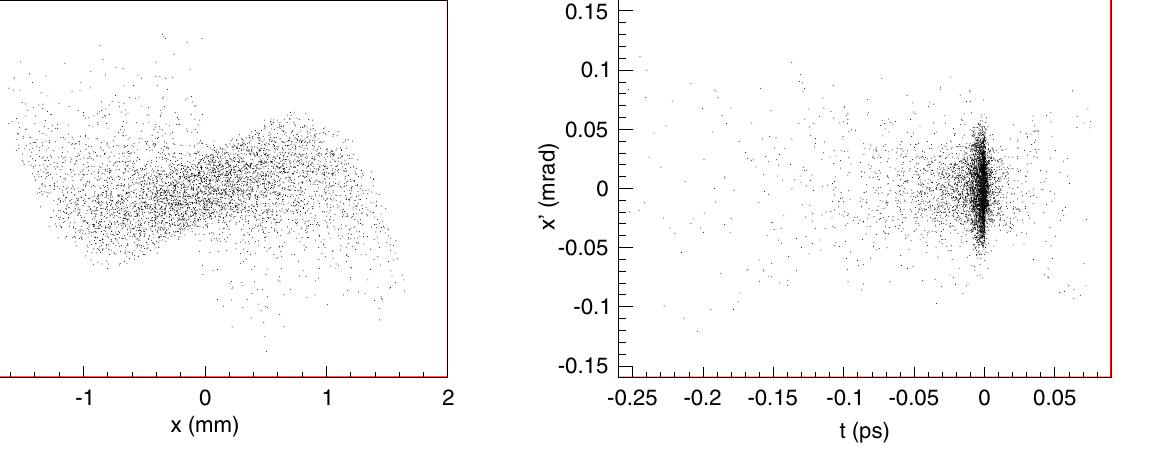
FIG. 10. Phase space consisting of time ( t ) and transverse angle ( x 0 ) of a beam at the sample location. The head and tail parts have relatively large transverse divergence compared to the main part around the peak.